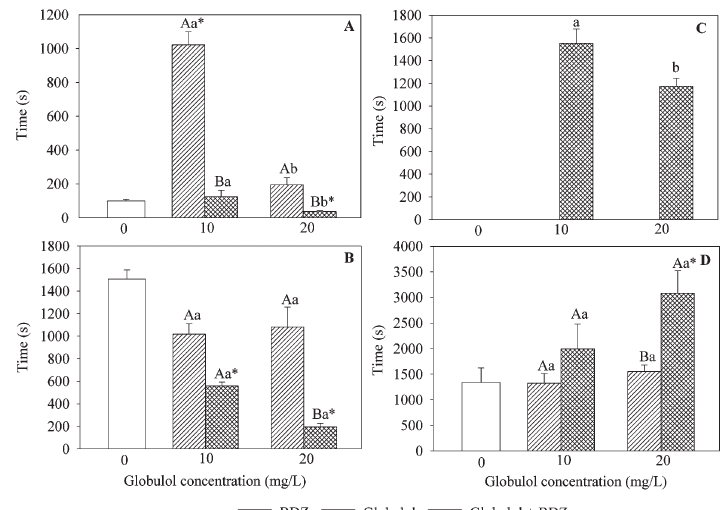
Figure 2. Time required for induction of anesthe- sia in silver catfish with globulol in association with benzodiazepine (BDZ): stage 2 ( A ), stage 3a ( B ) and stage 3b ( C ) according to Schoettger and Julin (22), and recovery time ( D ). Maximum observation time was 30 min to induction and 60 min to recovery. Time to reach each stage is given in seconds (s). Data are reported as means±SE (n=8). *Significantly different com- pared to BDZ; different uppercase letters indicate significant differences between globulol and association (globulol++BDZ) at the same con- centration; different lowercase letters indicate significant differences between concentrations of the same group. Two-way ANOVA and the Tukey test or Scheirer-Ray-Hare extension of the Kruskal-Wallis test and the Dunn test were used (P , 0.05). The control group of vehicle treatment is omitted because it did not produce any stage of